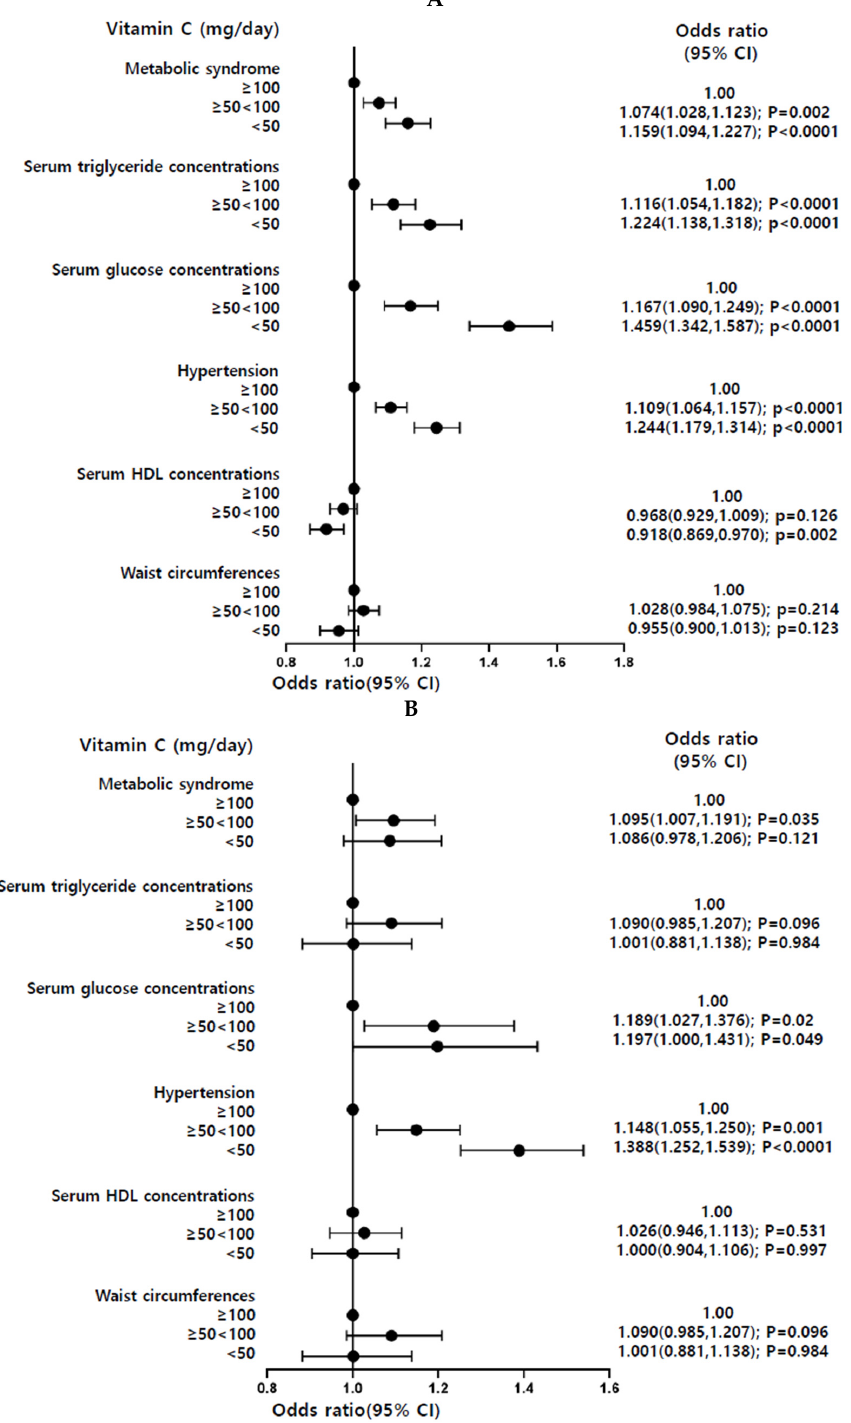
Figure 2. Association of dietary VC intake with the risk of metabolic syndrome (MetS) and its components in observational estimates. ( A ) City hospital-based cohort. ( B ) Ansan/Ansung plus rural cohorts. The reference in the logistic regression was the high VC intake ( ≥ 100 mg/day), and it was conducted by adjusting for age, gender, residential area, education, income, BMI, energy intake, exercise, smoking, and alcohol